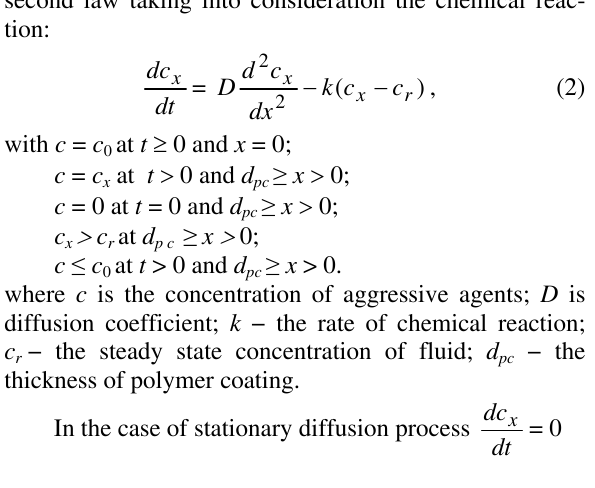
Table 1 . Classification of degradation of polymer coatings Type of